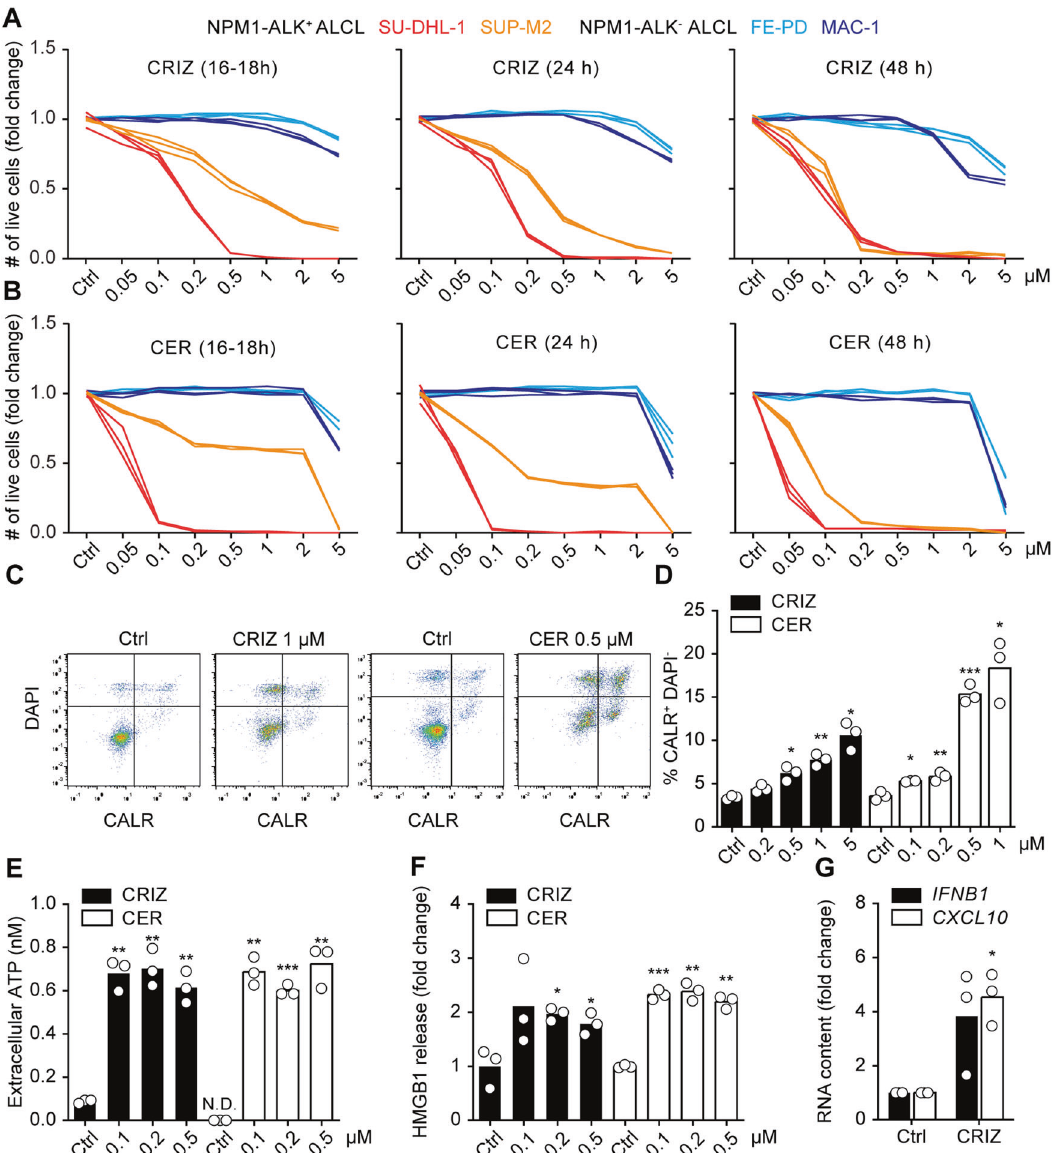
Fig. 1 Crizotinib- and ceritinib-induced immunogenic cell death. Human NPM1-ALK-positive (NPM1-ALK + ) SU-DHL-1 and SUP-M2 cells and the NPM1-ALK-negative (NPM1-ALK - ) FE-PD and MAC-1 cells were treated with increasing concentrations of crizotinib (CRIZ) (A) or ceritinib (CER) (B) for 16 – 18, 24, or 48 h. Cell death was evaluated using the mitochondrial transmembrane potential-sensible dye 3,3 ′ - dihexyloxacarbocyanine iodide (DiOC 6 (3)) and 4 ′ ,6-diamidino-2-phenylindole (DAPI). The number of live cells (DiOC 6 (3) + DAPI - ) normalized to vehicle control is represented for each replicate ( n = 3) ( A , B ). NPM1-ALK + SU-DHL-1 cells were treated with CRIZ or CER at the indicated concentrations, for 6 h, and calreticulin (CALR) exposed on the cell surface was quanti fi ed by fl ow cytometry using an indirect immuno fl uorescence staining. DAPI was used to exclude permeabilized cells. A representative gating strategy is shown in C, and the percentage of CALR + DAPI - cells is depicted in D ( n = 3). NPM1-ALK + SU-DHL-1 cells were treated with CRIZ or CER for 24 h and ATP secreted in the extracellular milieu was quanti fi ed using a luciferase-dependent assay. Individual values are depicted in E ( n = 3). NPM1-ALK + SU-DHL-1 cells were treated with CRIZ or CER for 48 h and high mobility group box 1 (HMGB1) was quanti fi ed in the supernatant using a speci fi c ELISA. Fold increase for each replicate is shown in F ( n = 3). One representative out of three independent experiments is shown A – F . NPM1-ALK + SU- DHL-1 cells were treated with 0.1 μ M of CRIZ for 16 – 18 h. IFNB1 and CXCL10 upregulation was assessed by quantitative PCR using speci fi c fl uorescently labeled primer – probe sets. GAPDH was used as housekeeping gene. Fold changes of three independent experiments are shown ( G ). Statistical signi fi cance was calculated using the Student ’ s t test. * p < 0.05, ** p < 0.01, *** p < 0.001 vs. vehicle-treated cells ( D – G ). N.D. non-